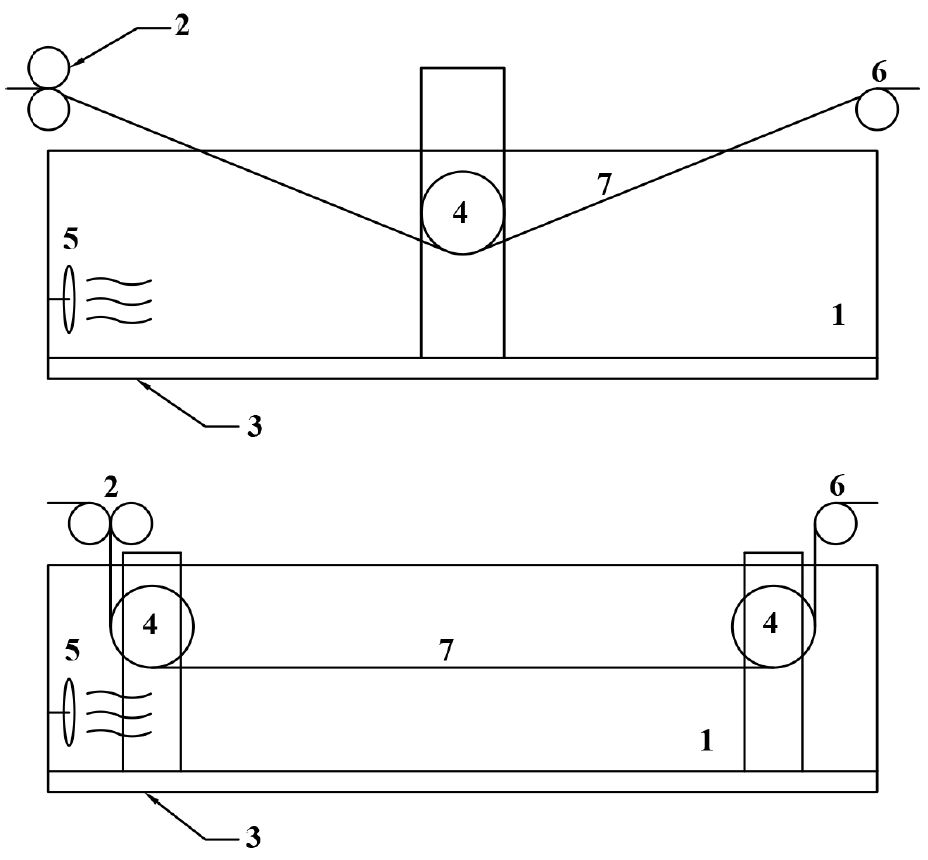
Figure 1. Schematic diagram of the device for treatment of paper substrate surface: 1—heated tank (bath) with solvent; 2—pressing rollers; 3—heater; 4—directing rollers; 5—pump for solvent; 6—feeding rollers; 7—cellulose substrate.